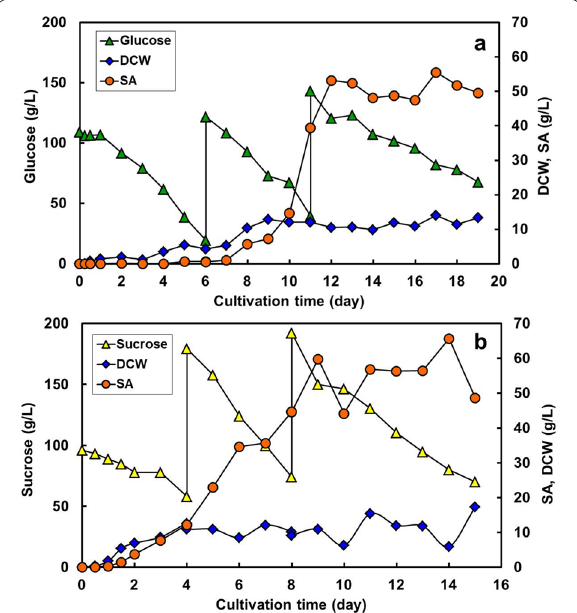
Fig. 10 Fed‑batch culture for spiculisporic acid production from different carbon source by T . trachyspermus NBRC 32238. a Glucose culture, with feeding of additional sugar, at 6 and 12 days. b Sucrose culture, with feeding of additional sugar, at 4 and 8 days. The cultures were contained 4.5 g/L meat extract, and 5.0 g/L FeCl 3 and operated in an aeration stirring‑type reactor containing 1 L medium controlled at 28 °C and 700 rpm with an aeration rate of 0.5 vvm for 19 days in case of glucose culture and for 15 days in case of sucrose